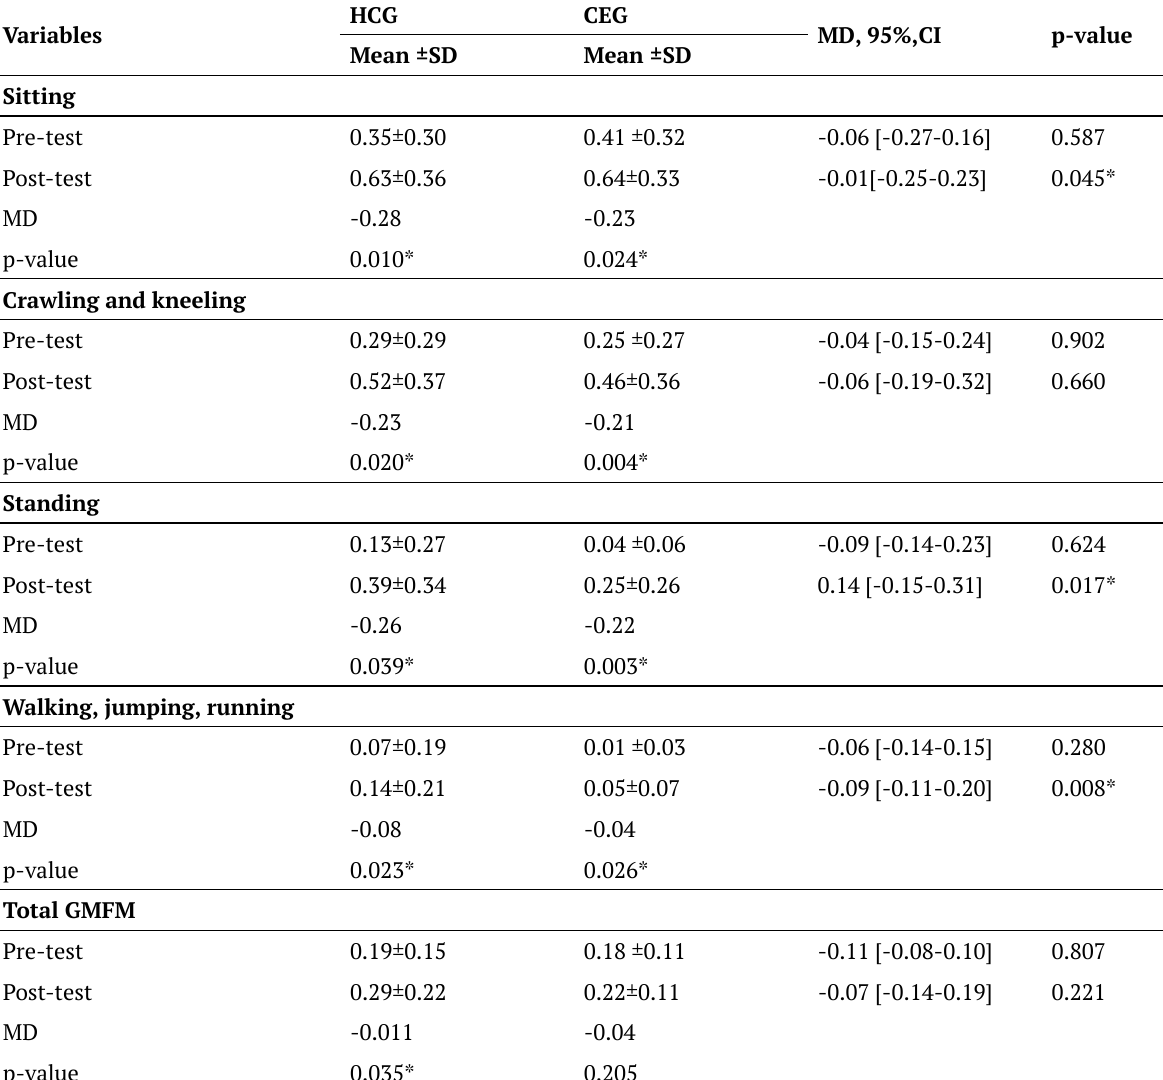
Table 3. Mean ±SD the five GMFM dimensions before and after treatment in both